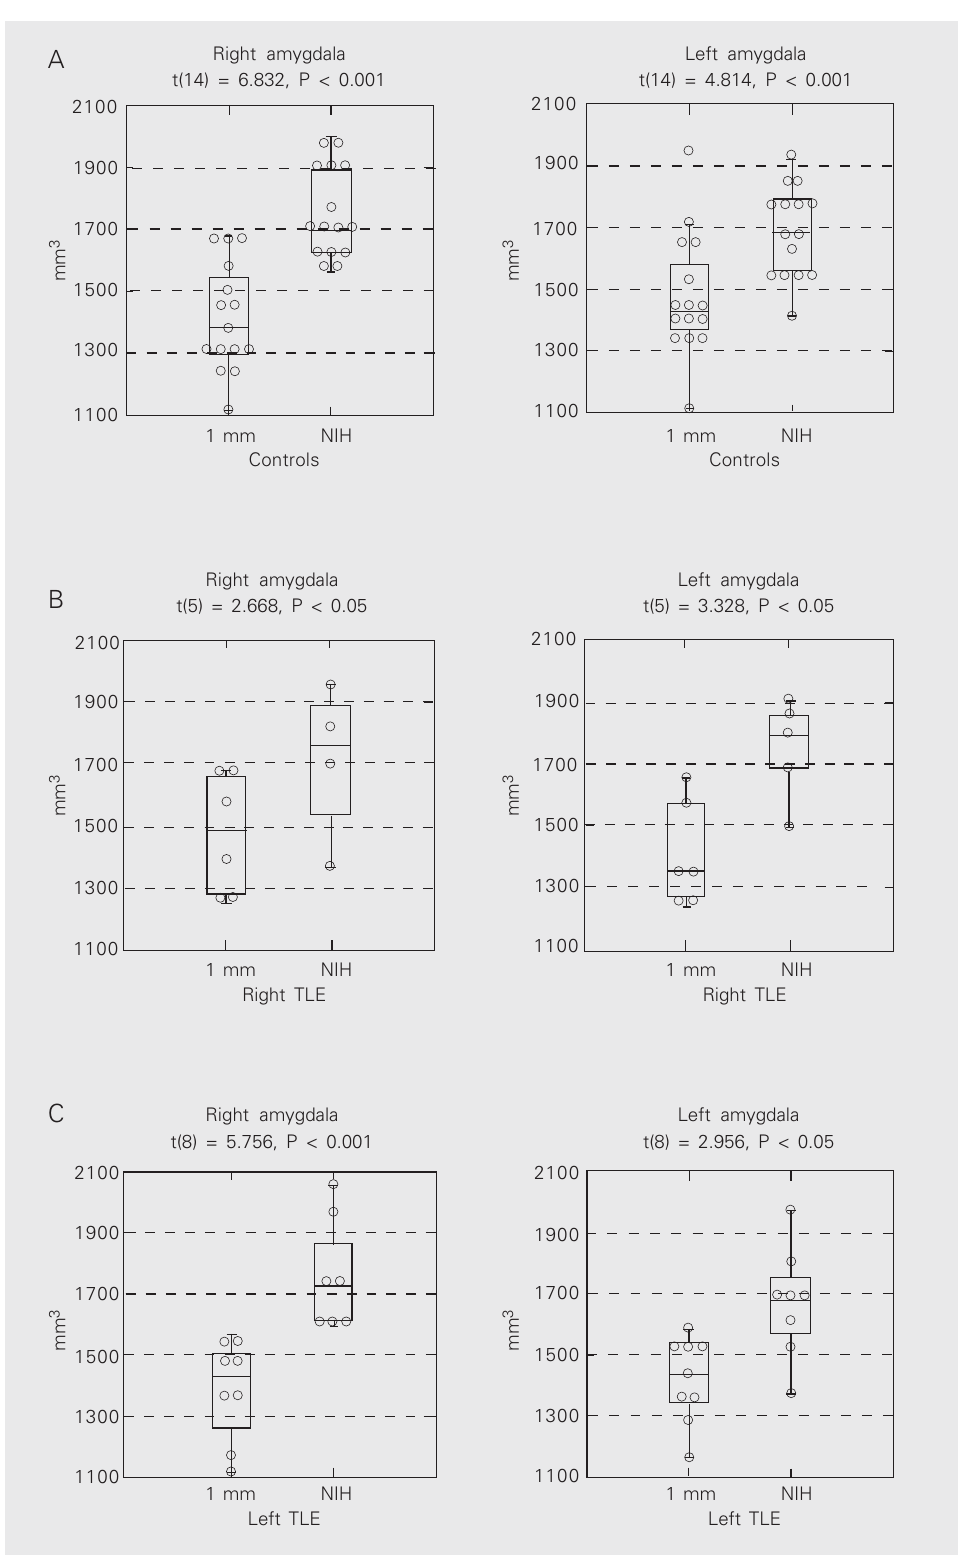
Figure 3. Box and whisker plots of amygdala volumes of con- trols (A), right TLE (B) and left TLE (C) measure on coronal plane-based segmentation and multiplanar analysis. Legend: 3 mm - coronal plane based anal- ysis, 1 mm - multiplanar analy- sis. TLE = temporal lobe epi- lepsy; NIH = NIH image, Na- tional Institutes of Health soft-